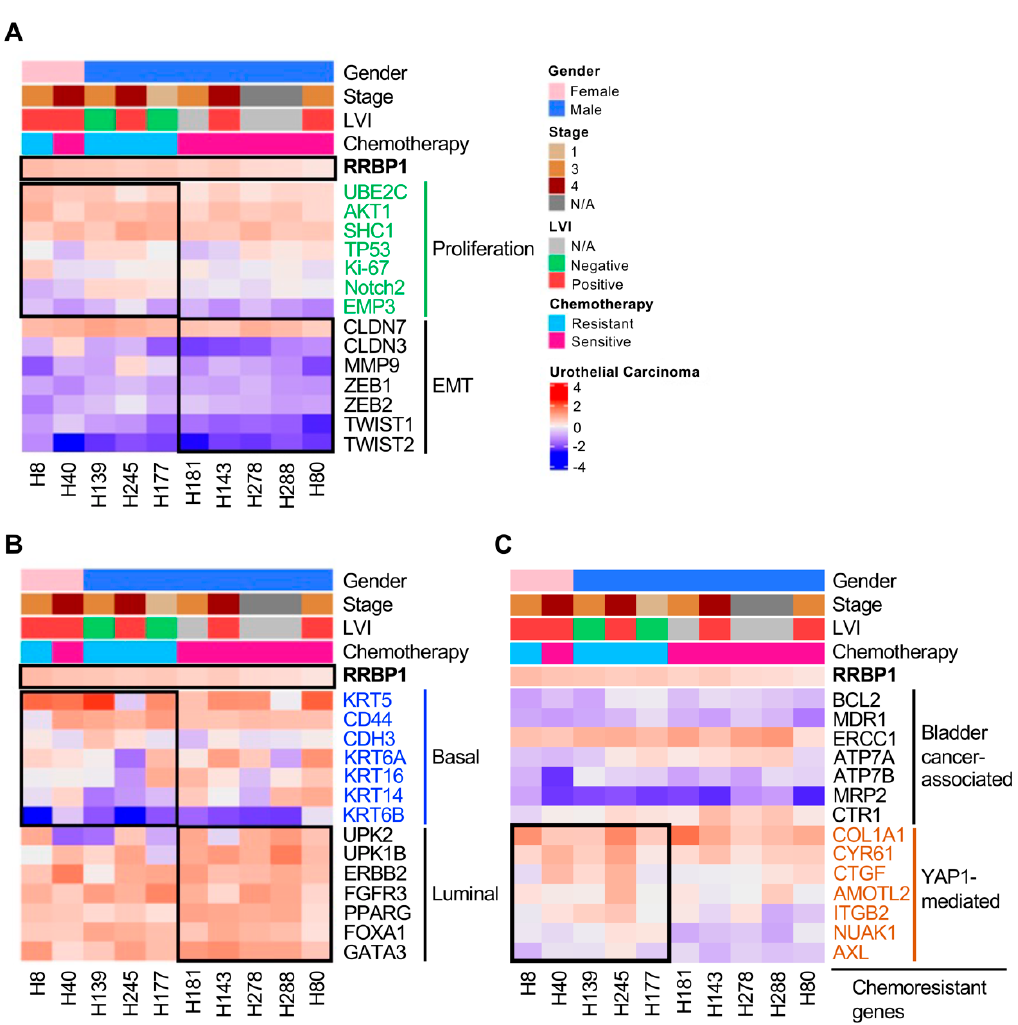
Figure 5. Analysis of mRNA expression of molecular subtypes according to the level of RRBP1 in UTUC. Heatmap analysis of mRNA expression represented a high correlation between RRBP1 and chemotherapy. RNA expression of molecular subtypes was analyzed according to the level of RRBP1. Ten samples were analyzed using the unlinked database from the National Health Institute. ( A ) Clustering of genes for the proliferation and EMT biomarkers. ( B ) Clustering of genes for the basal and luminal biomarkers. ( C ) Clustering of genes for bladder-cancer-associated and YAP1-mediated chemoresistant genes.